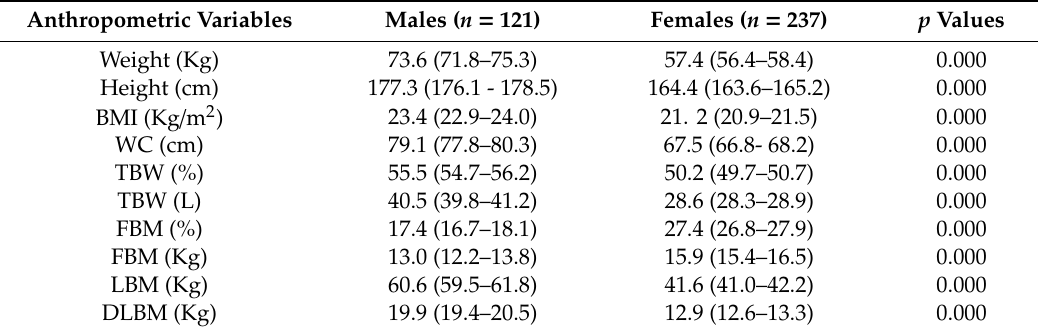
Table 1. Anthropometric characteristics of participants from the study.